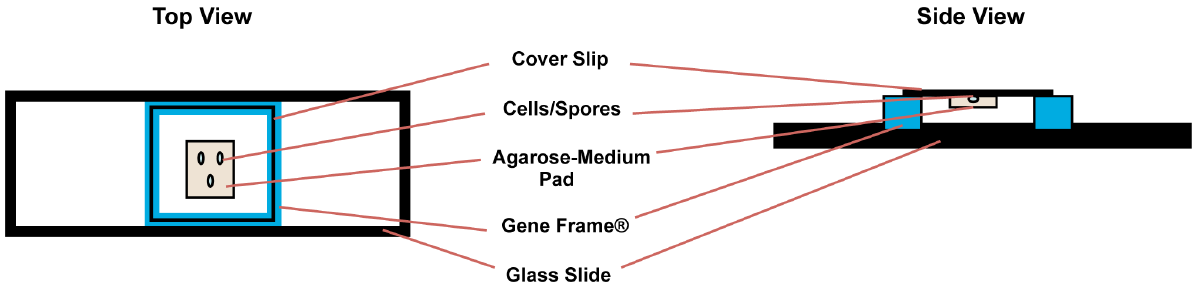
Figure 1. Schematic picture of the top and side view of the designed closed air-containing chamber for live cell imaging. A chamber was prepared by attaching a Gene Frame H to a standard microscope slide and cover slip. A thin, semisolid matrix pad (160 m m) of 1% agarose – medium was made. The pad was loaded with exponentially growing vegetative cells or heat-activated spores. The cover slip was placed in upside down position onto the Gene Frame H (See Materials and Methods for details).